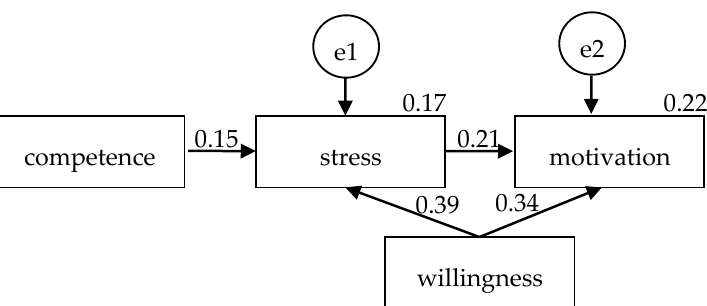
Figure 3. Parameter estimates of willingness to participate in disaster management, disaster nursing competence, disaster stress, and motivation for disaster